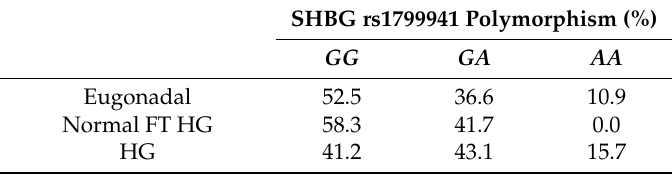
Table 2. Genotype for the SHBG polymorphism rs1799941 among the different groups of study. Values are given as the percentage of the frequencies.